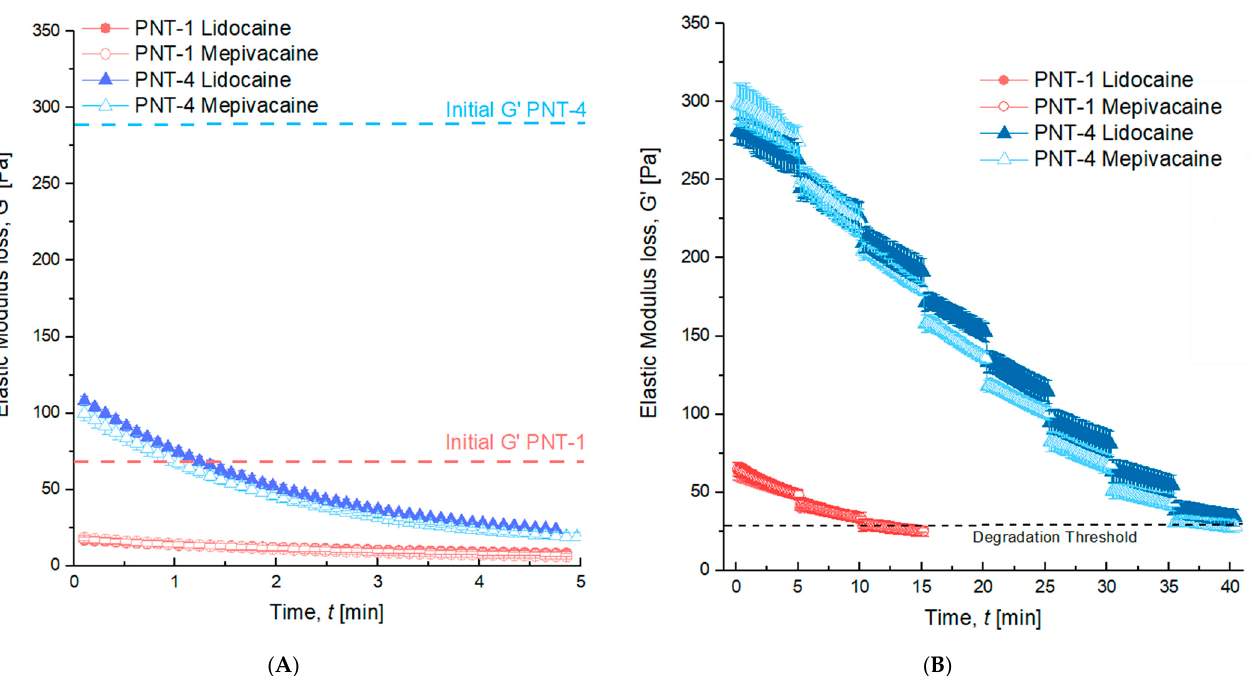
Figure 3. Enzymatic degradation test of PNT-1 and PNT-4 in presence of lidocaine or mepivacaine. ( A ) Fast degradation test with a high enzyme dose. The test highlighted the rapidness of degradation (5 min) of PNT-1 and PNT-4 with no influence of the anesthetic, which is mandatory for these kinds of medical devices in case of adverse events. ( B ) Persistence test with multiple low enzyme doses. This test showed similar behaviors of the gels either with lidocaine or mepivacaine, suggesting a similar clinical duration for each formulation either with lidocaine or mepivacaine. Each test was performed on 3 different HA gels for each formulation ( n = 3). No significance was noticed between lidocaine and mepivacaine formulations.